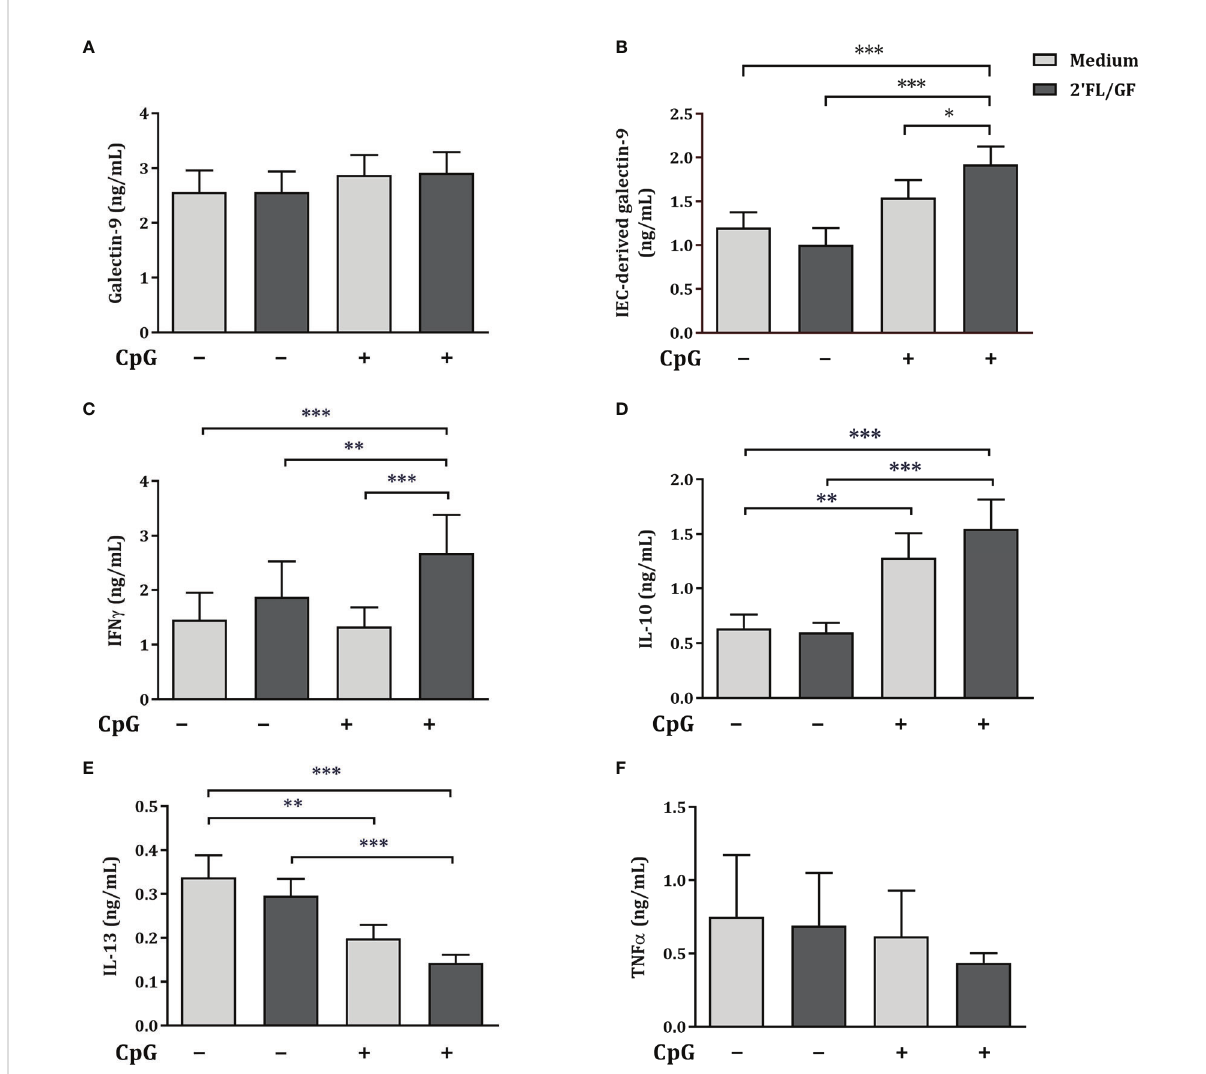
FIGURE 3 Cytokine and galectin-9 secretion in IEC/PBMC co-culture. IEC (HT-29 cell line) were stimulated with a 1:1 mixture of 2 ’ FL and GF (0.5% w/v ) in combination with CpG (0.5 µM) and basolaterally exposed to a CD3/CD28-activated PBMC for 24 h. After incubation, galectin-9 (A) , IFN g (C) , IL- 10 (D) , IL-13 (E) and TNF a (F) were measured in the basolateral supernatant. Additionally, after IEC/PBMC co-culture, HT-29 IEC were washed and incubated in fresh medium for additional 24 h (total 48h; 24h IEC/PBMC co-culture and additional 24h IEC culture) after which IEC-derived galectin-9 (B) was measured in the basolateral supernatant. Data are represented as mean ± SEM of n = 6 (E) , n = 7 (A, B, E) or n = 8 (A, C, D) independent PBMC donors (# p < 0.1, *p < 0.05, **p < 0.01, ***p <